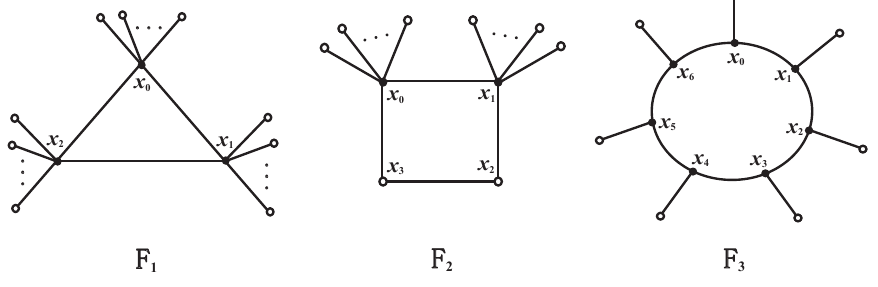
Figure 1. Configurations F 1 , F 2 , and F 3